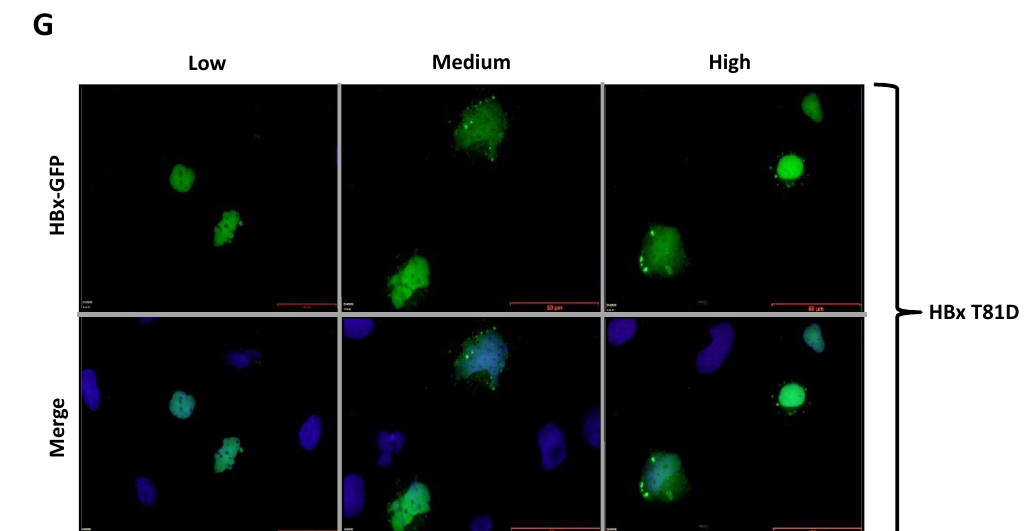
Figure 3. Fluorescence of the HBx-GFP protein and point mutant in cells. ( A ) Fluorescence of hepatoma cells transfected with low (left), medium (middle), and high (right) amounts of plasmid DNA containing HBx protein tagged with GFP. Bottom panel shows nuclear DAPI signal merged with that of GFP fluorescence. ( B ) HBx S25A, ( C ) HBx S25D, ( D ) HBx